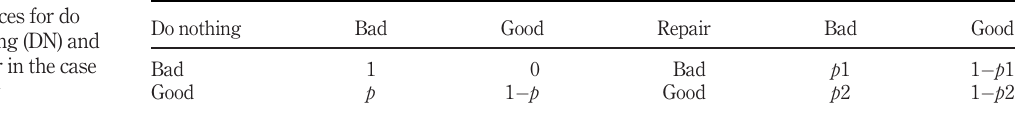
Table 1. Markov transition matrices for do nothing (DN) and repair in the case